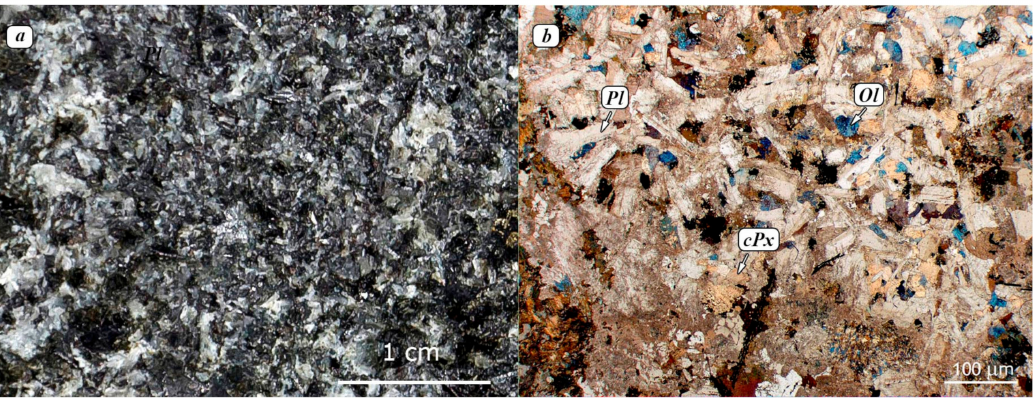
Figure 9. Hand specimen photo ( a ) and microphotogaph ( b ) of sample BT-1 / 114.6